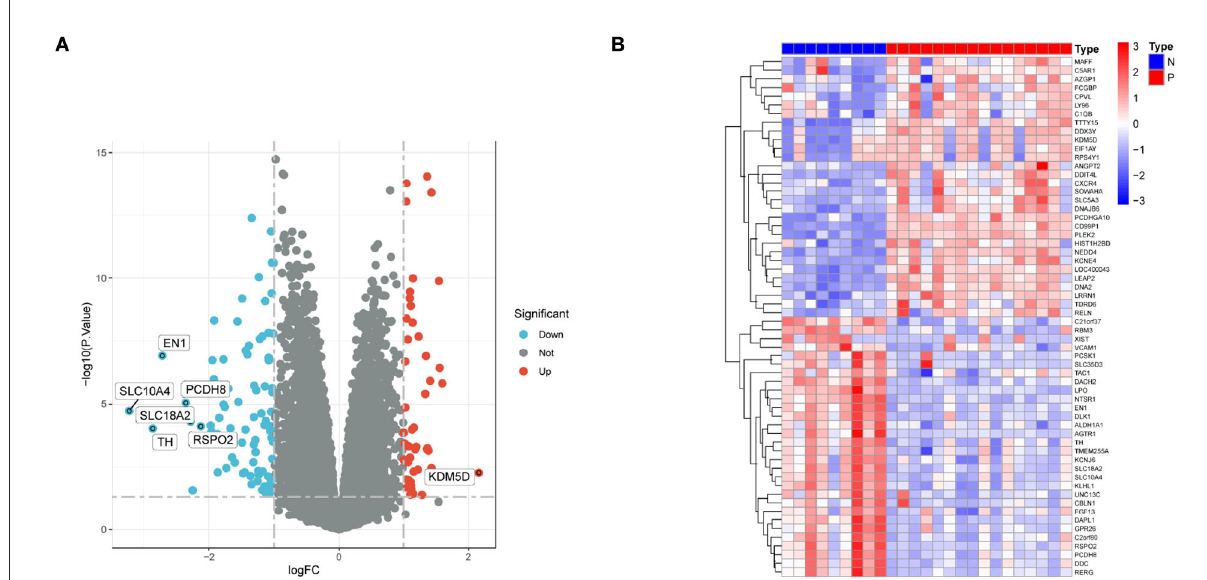
FIGURE1 DEGs between PD patients and normal samples. (A) Volcano plot showing the expression levels of DEGs. Red dots indicate upregulated genes in PD patients compared with normal samples. In contrast, blue dots indicate downregulated genes in PD patients compared with normal samples, and gray dots indicate nonsignificant differences in genes between PD patients and normal samples. (B) Heat map showing the expression levels of the top 60 DEGs. Red indicates high expression, while blue indicates low